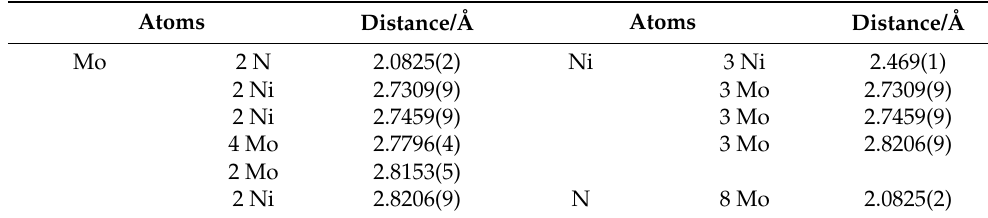
Figure 4. Crystal structure of Mo 3 Ni 2 N with corner-sharing distorted octahedra centered by N. Table 3. Selected interatomic distances in Mo 3 Ni 2 N.